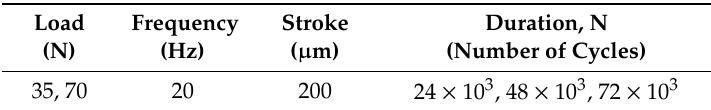
Figure 1. Schematic diagram of ball-on-disk fretting tribometer. Table 2. Main test parameters.